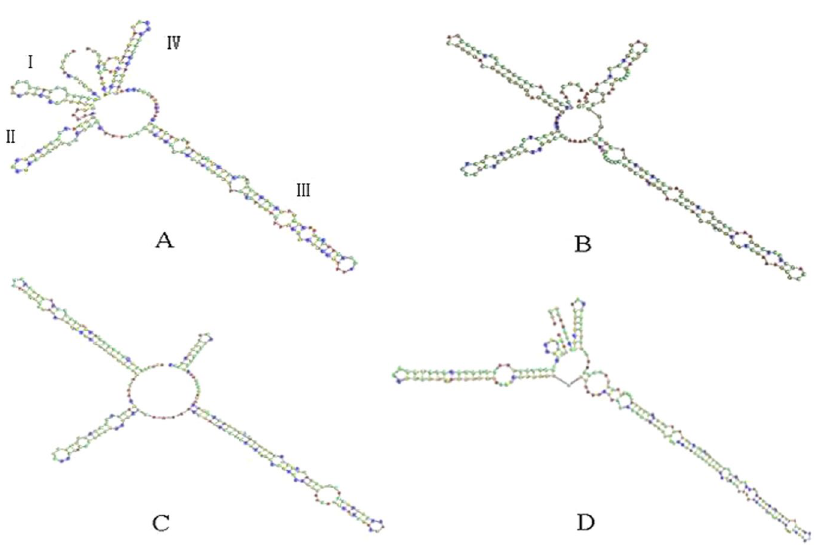
Figure 2. Secondary structure of ITS2 in T . jasminoides and its adulterants. ( A ) T . jasminoides ( B ) E . fortunei ( C ) F . tikoua ( D ) F . pumila